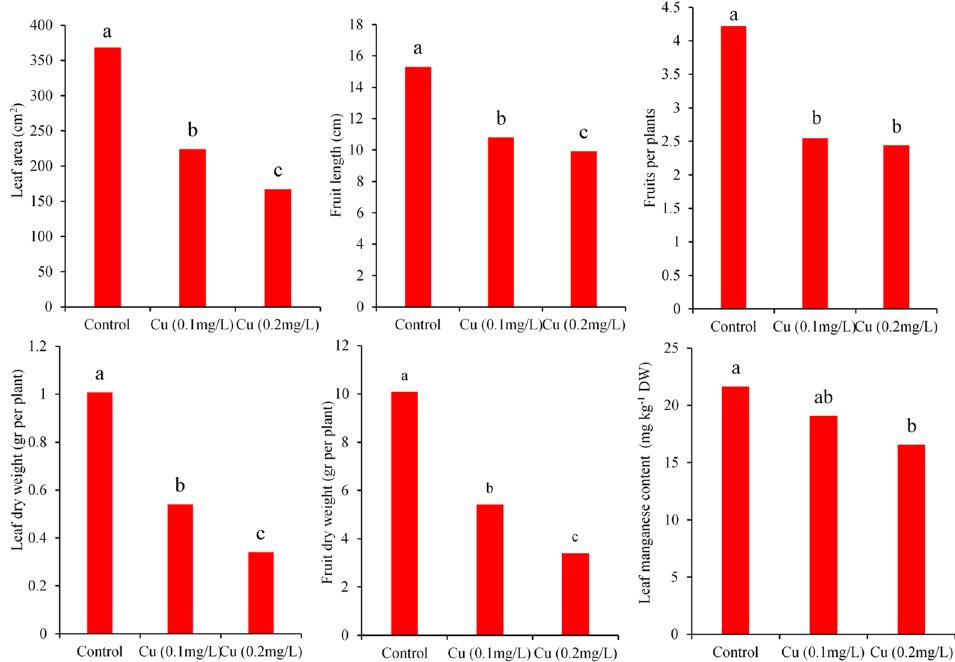
Figure 2. Main effects of added Cu concentration on growth traits and leaf Mn content of C. pepo L. The plot represents means of triplicates. Different alphabetic letters on each bar show significant differences at the 5% level between simple effects of treatments according to Duncan’s multiple range mean comparison test.